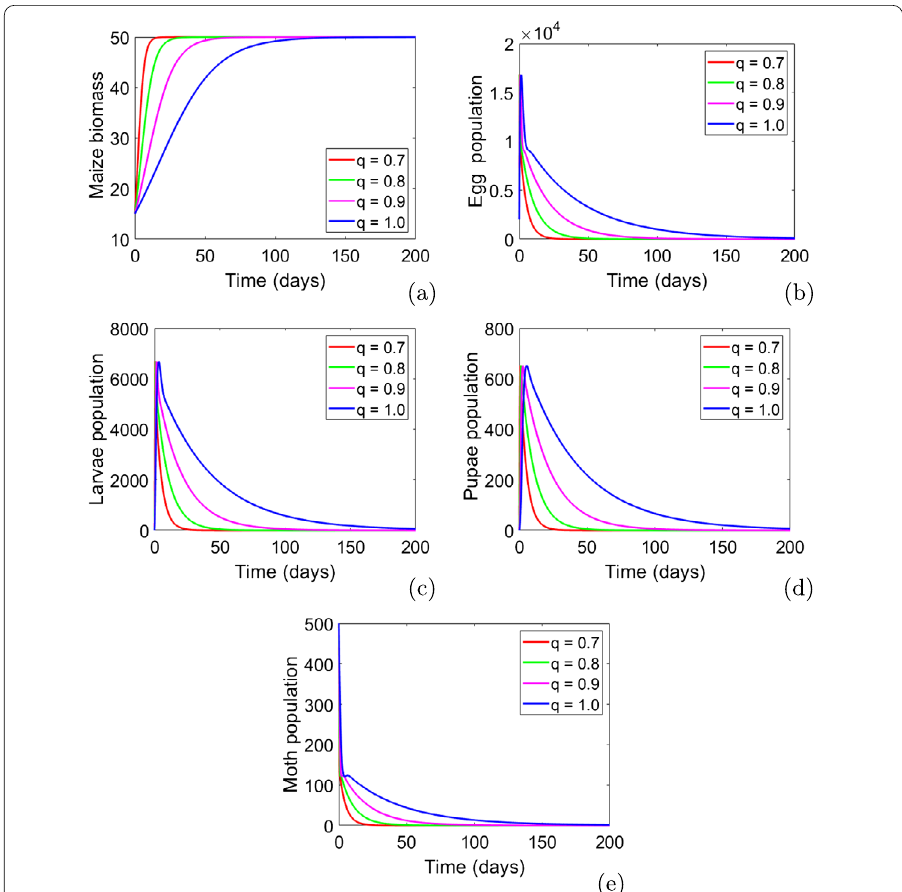
Figure 4 Numerical results of system (1) demonstrating the convergence of solutions to the pest-free equilibrium for R 0 ≤ 1. On construction of the simulations, we considered initial population levels discussed earlier, while baseline values for the model parameters are as in Table 2. In addition, we set u E = u L = u P = u A = 0.52 to obtain R 0 = 0.8630. We can note that whenever R 0 < 1, the pest population becomes extinct while maize biomass increases with time, reaching its expected maximum of 50 kg plant –1